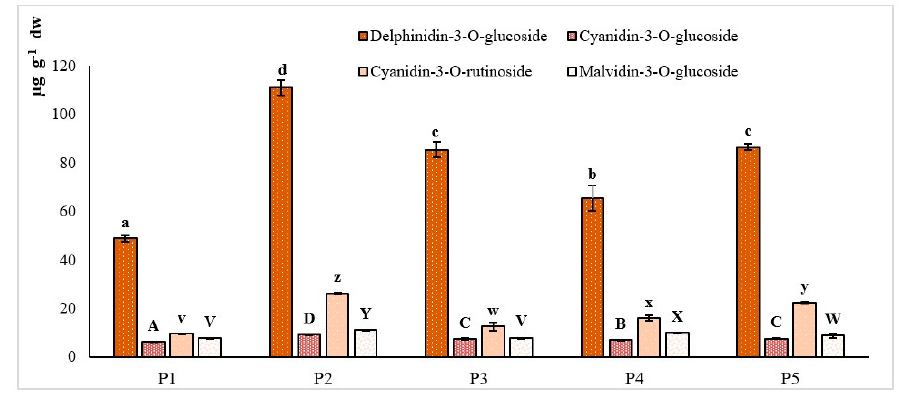
Figure 4. HPLC–DAD quantification of individual anthocyanins ( μ g g − 1 ) of different extracts analyzed (mean ± SD).